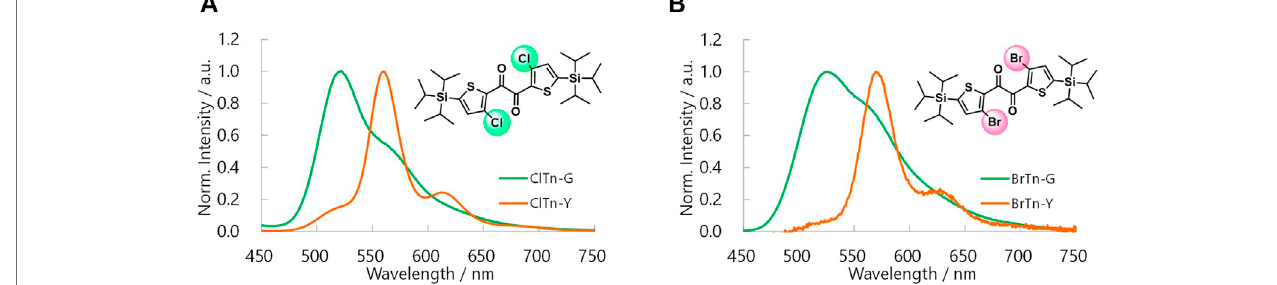
FIGURE 3 | Steady-state PL spectra of (A) ClTn and (B) BrTn at room temperature in air. λ ex (cid:2) 320 and 360 nm for the G and Y phase samples, respectively.